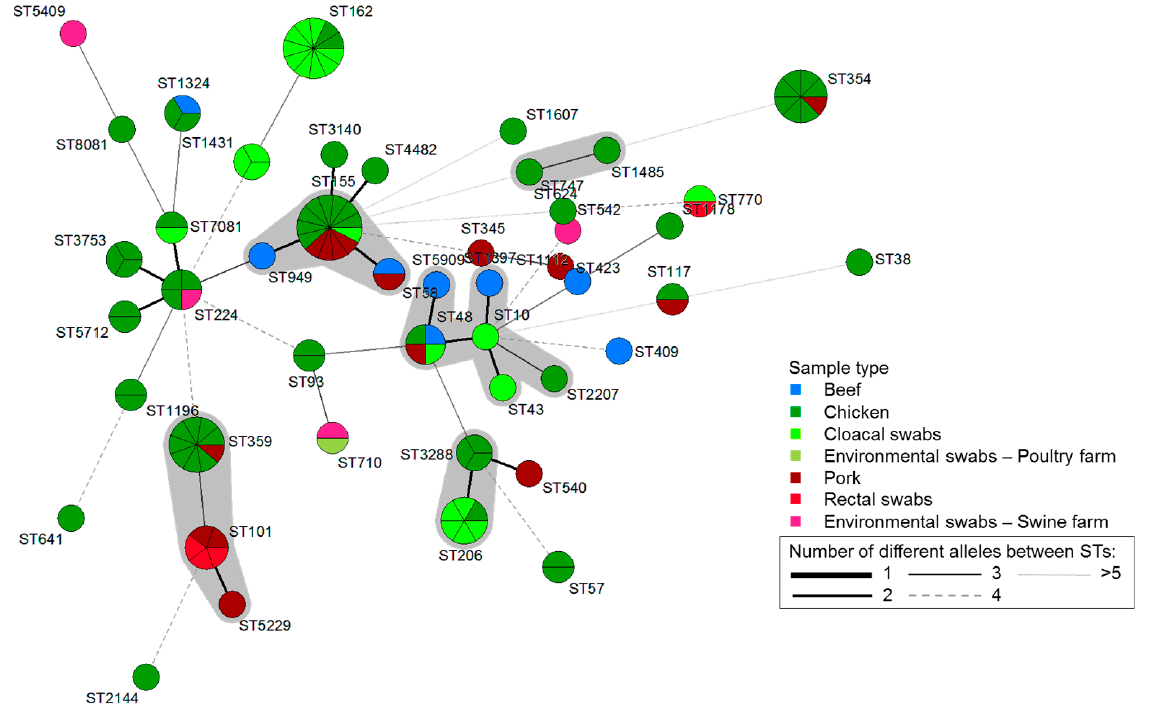
Figure 2. Minimum spanning tree based on multilocus sequence typing alleles of 115 QRDR/PMQR-harboring E. coli isolates from beef, chicken, pork, cloacal swabs, rectal swabs, and environmental swabs. Each circle corresponds to an individual sequence type (ST), and the circle size indicates the number of isolates assigned to the same ST. The color of the circle denotes the sample type. The connecting lines (solid and dashed) between circles denote allelic variations between STs, and the gray shadowing indicates STs belonging to the same clonal complex (CC). The majority of the isolates were assigned to phylogenetic group B1 (55.7%) ( p < 0.05), followed by group A (28.7%) and group D (15.7%). None of the isolates belonged to phy- logenetic group B2 (Figure 1). While isolates with amino-acid substitutions in QRDRs were significantly associated with phylogenetic group B1 ( p < 0.05), isolates harboring PMQR genes were significantly associated with phylogenetic group A ( p < 0.05). In con- trast, isolates that harbored both QRDR and PMQR genes were distributed evenly among phylogenetic groups (A, B1, and D) (Figure 3). Figure 3. Prevalence of phylogenetic groups in 115 isolates not susceptible to quinolones but har- boring mutations in QRDR and/or PMQR genes, from food-producing animals and their food products, collected in the Philippines. * The p -value was significant ( p < 0.05).